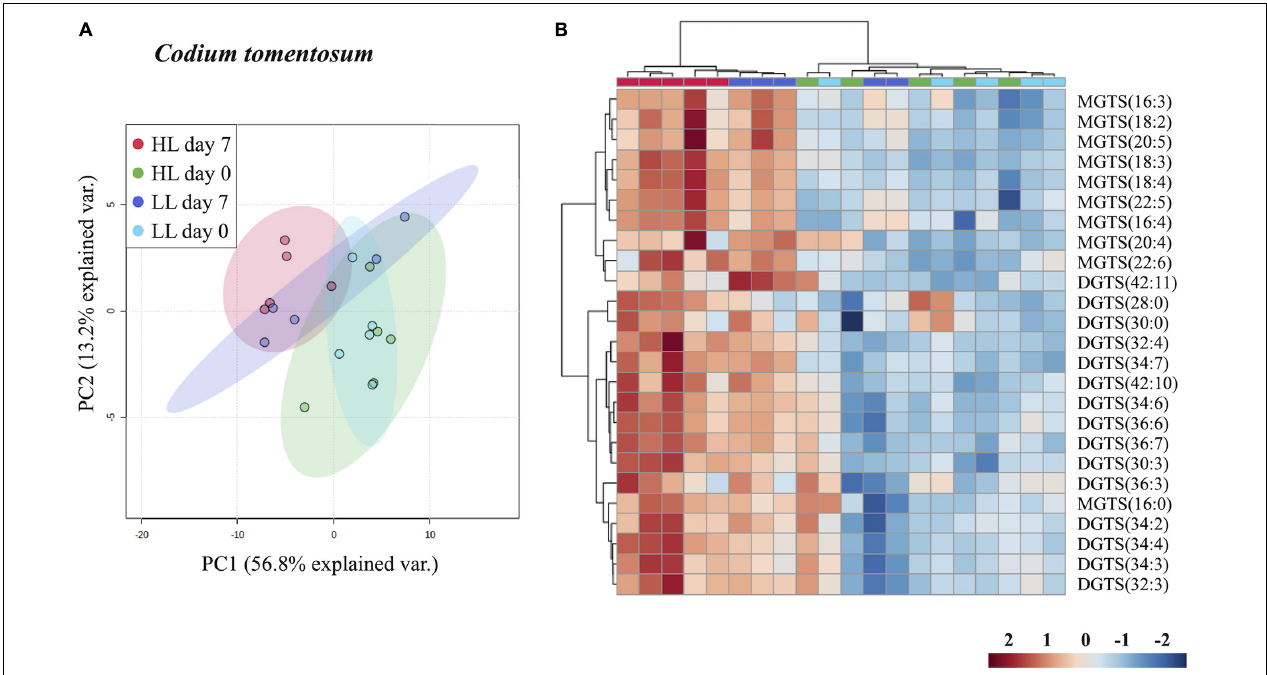
FIGURE 8 | Principal component analysis (PCA) and heatmap/clustering analysis of betaine lipids profile discriminating Codium tomentosum at low light (LL) and high light (HL) at the beginning (day 0) and at the end (day 7) of the light acclimation. (A) PCA 2D score plot; (B) heatmap/clustering analysis. PCA scores plot were performed using the complete betaine lipids dataset (normalized XIC areas) while for heatmaps/clustering analysis the 25 molecular species that most contributed to differentiation between treatments were selected (PLS-DA